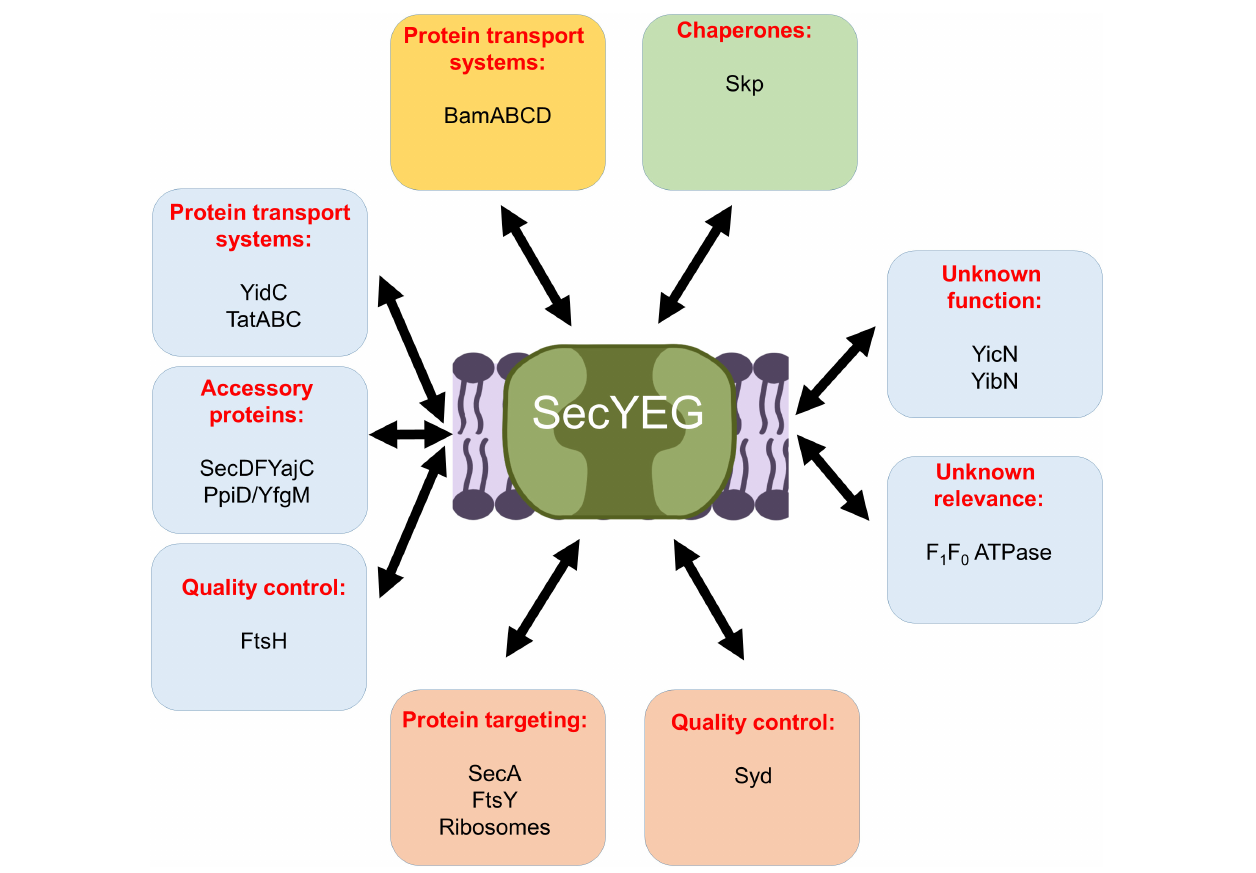
FIGURE 9 | Schematic view on the protein interaction network of the E. coli SecYEG complex. Interactions within the inner membrane are shown in blue boxes, those that take place at the cytosolic phase of the inner membrane in orange boxes, those at the periplasmic side of the inner membrane in a green box, and those with the outer membrane are boxed in yellow. For details see